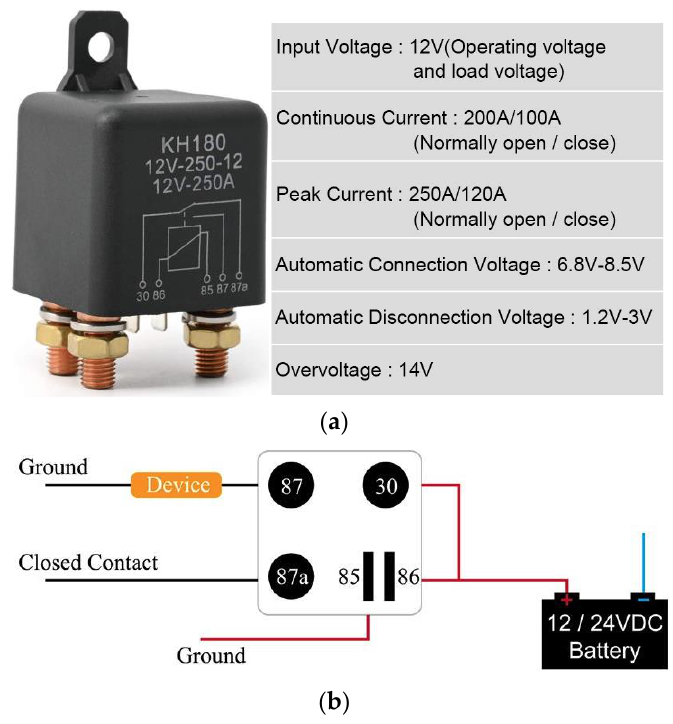
Figure 3. Battery relay: ( a ) relay properties; ( b ) connection to the battery.